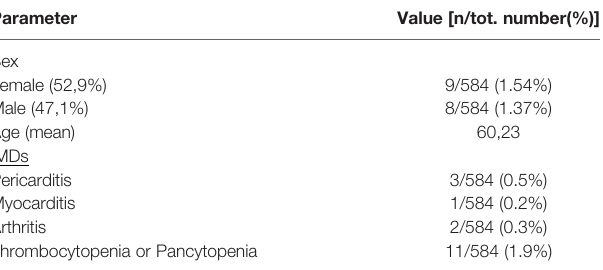
TABLE 2 | Immune-Mediated Diseases (IMDs) diagnosed in patients hospitalized for COVID-19. Parameter Value [n/tot.